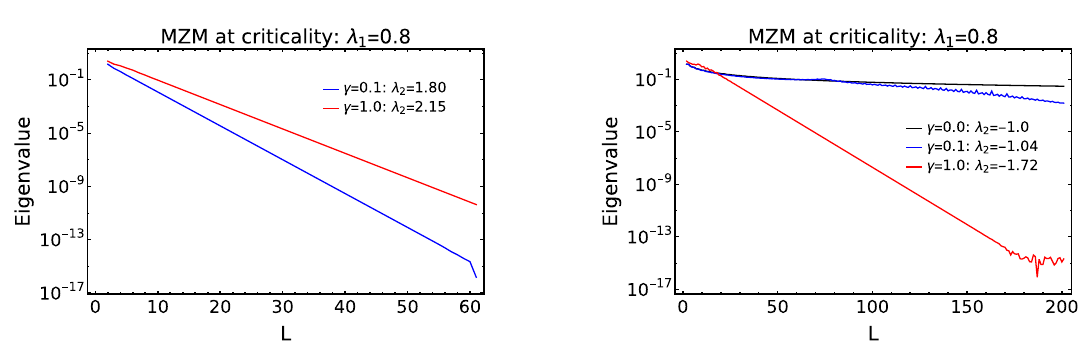
Figure 7. Phase diagram of (cid:31) 2 with (cid:31) 1 . All the intersecting points on the negative (cid:31) 2 axis in the right plot are the positions of multicritical point for different values of γ .